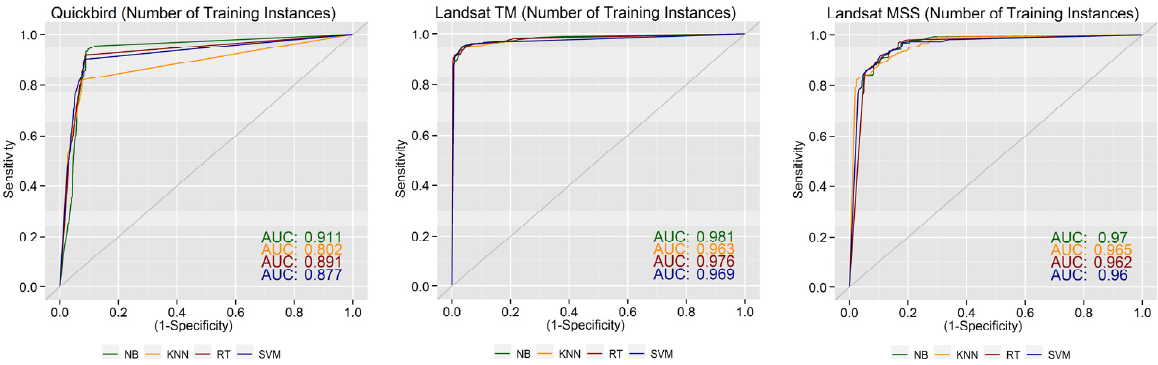
Figure 7. ROC curves for the classification of QB, TM and MSS, depicting the performance of different classifiers under varying numbers of training